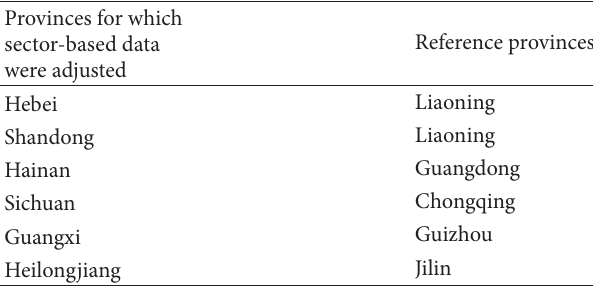
Reference provinces